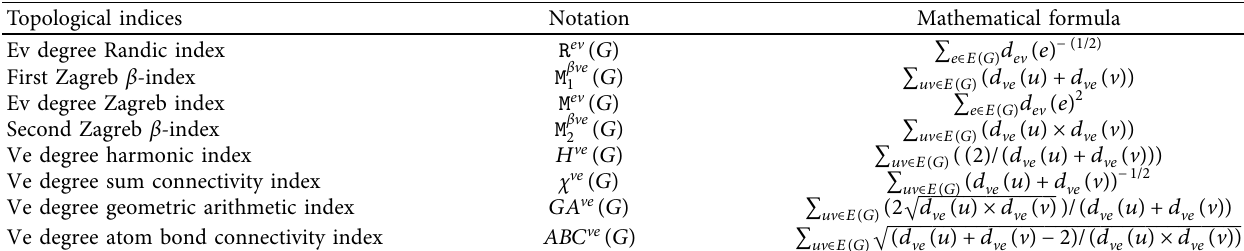
Table 1: Mathematical formula of topological indices.